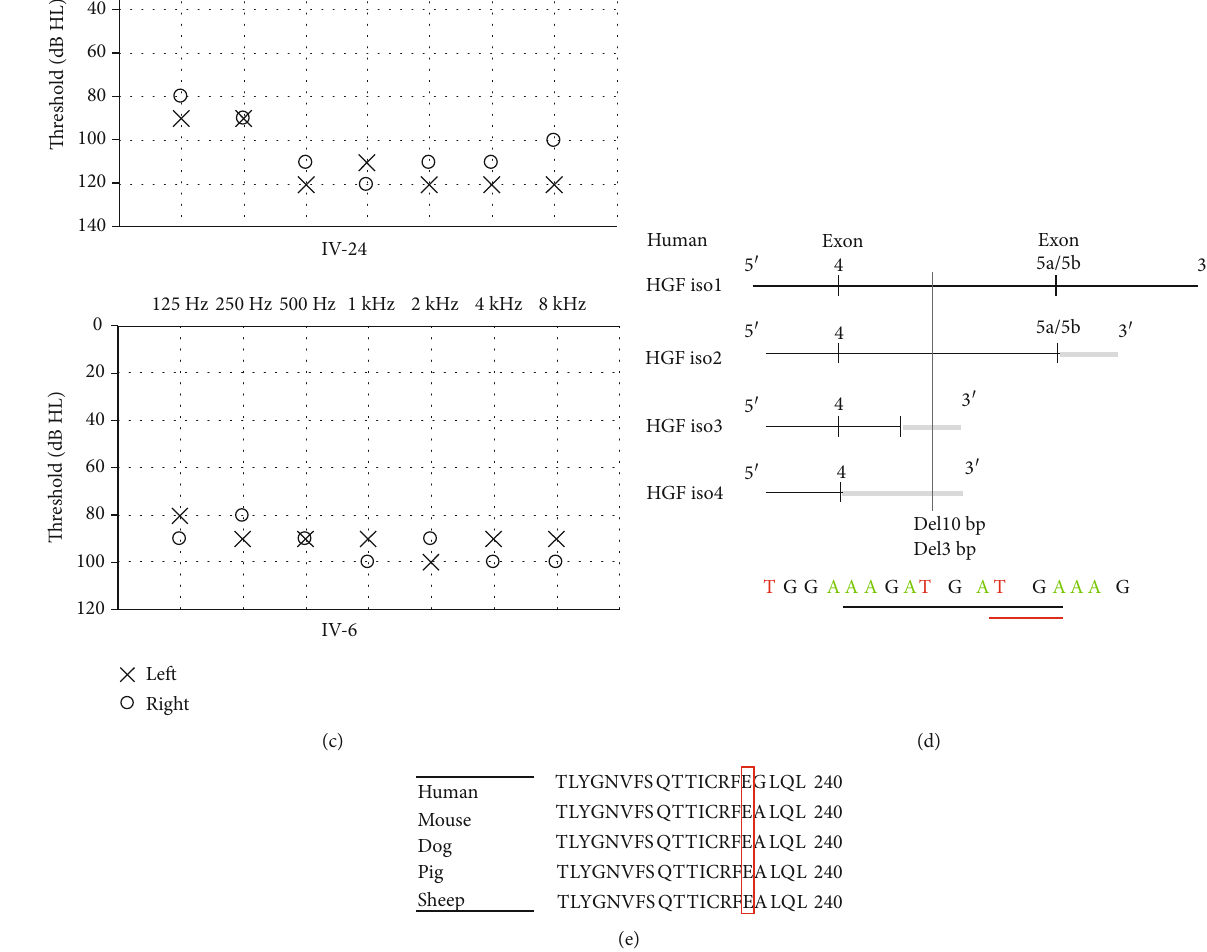
Figure 3: Genetic and phenotypic characterization of Family PK-DB-OKA-01. (a) Pedigree and genotypes showing the 482+1986-1988del variant in HGF (marked as -) and the c.706G > A (p. Glu236Lys) variant in POU3F4 (marked as X - ). (b) Sanger sequencing of the 482 +1986-1988del and c.706G > A (p. Glu236Lys) variants. (c). Pure tone audiometry showing the bilateral profound hearing loss in a ff ected family members IV-24 and IV-6. (d) Position of the 3 bp deletion in human HGF and the 10 bp deletion in mouse Hgf that both lead to profound hearing loss. (e) Multiple sequence alignment showing the conservation of the E236 residue in di ff erent